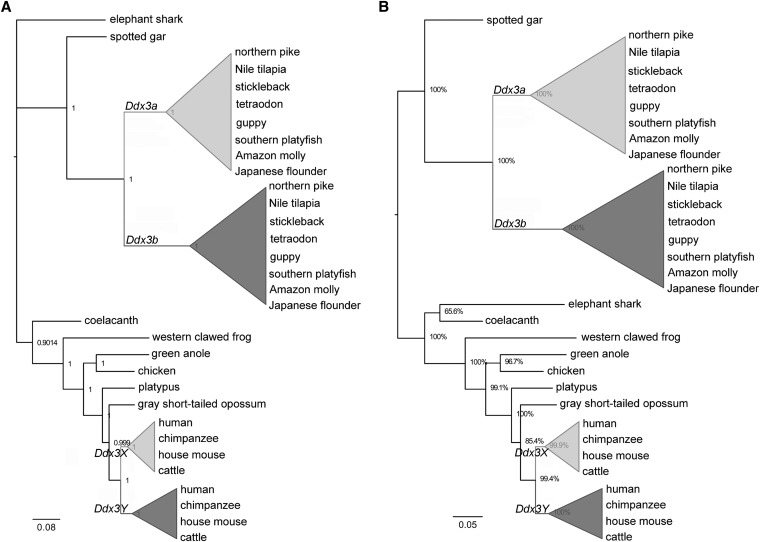
Phylogenetic analyses of vertebrate Ddx3 genes. (A) Bayesian method was used to construct the gene tree. Numbers at the nodes are Bayesian posterior probabilities. Scale bar = 0.08 substitutions per site. (B) The gene tree was built by the maximum likelihood method. Numbers at the nodes are bootstrap support values with a percentage based on 1000 replicates. Scale bar = 0.05 substitutions per site. Phylogenetic reconstructions were based on the coding sequences of Ddx3 genes. The accession numbers of these genes at GenBank or Ensembl database are provided in Table S1. Elephant shark Ddx3 was used as the out-group. Teleost Ddx3a or Ddx3b genes that clustered together are marked as a cartoon clade, as are the eutherian Ddx3X/Y genes.